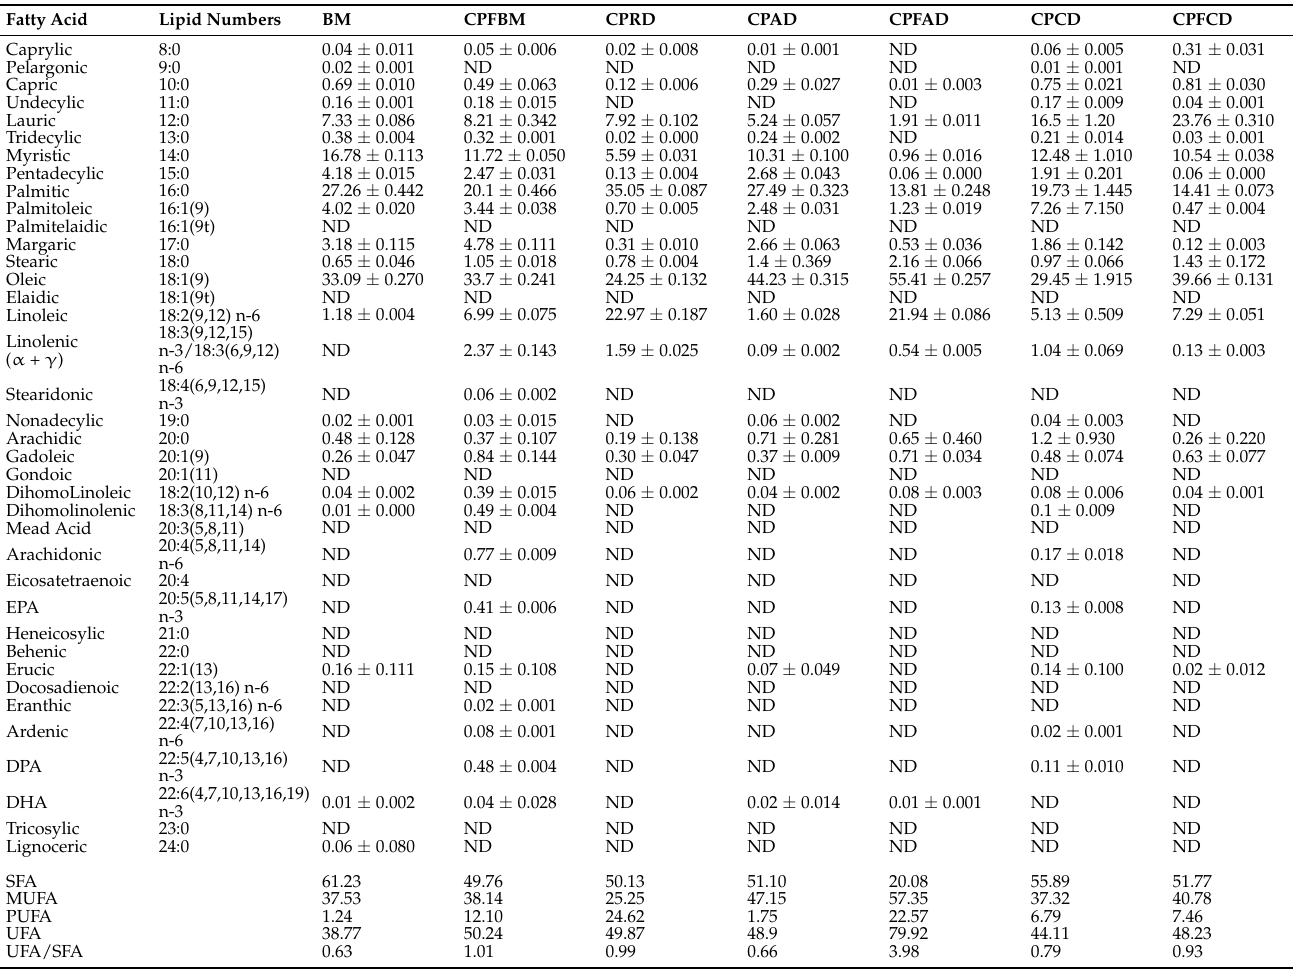
Table 3. Fatty acid composition of commercially purchased dairy and dairy alternative